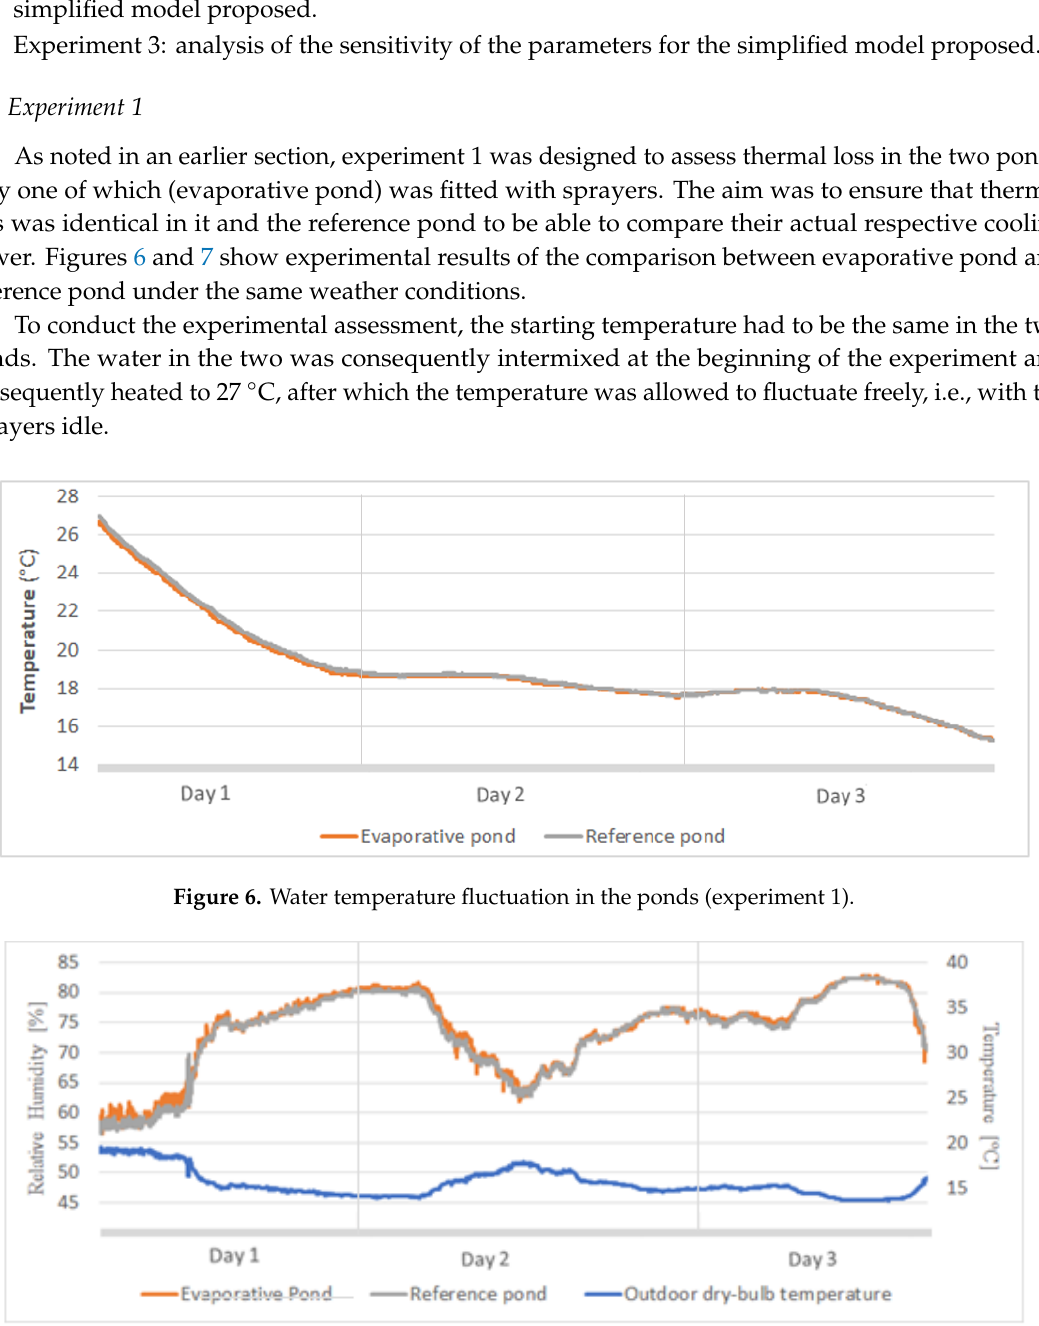
Figure 7. Relative humidity and dry-bulb temperature fluctuation in the ponds (experiment 1).